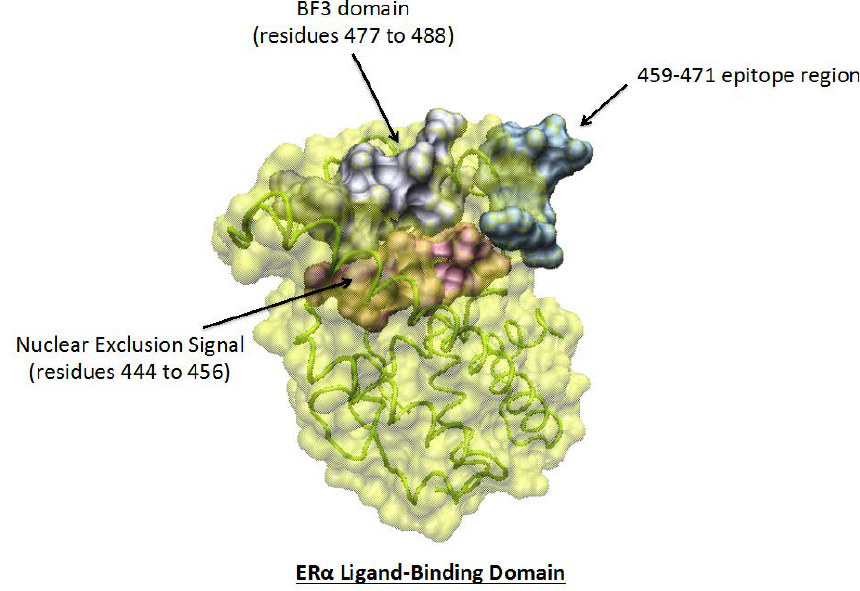
Figure 4. Surface structure of the BF3- (in grey) and ER α AB epitope/E 2 (in blue)-binding domains of the human estrogen receptor α (ER α in yellow, Connolly surface). The BF3 domain is composed of two regions, i.e., the 365–369 type II β -turn region and the 477–488 helix 10 (H10) region, the latter overlapping the 479–485 sequence implicated in the dimerization of the receptor. The ER α ABs epitope is in close contact with this BF3 domain, as well as the 444–456 nuclear exclusion site (nes, for nuclear exclusion signal, in pink). Interaction between the 301–311 region with the 365–269 type II β turn seems to repress the dimerization potency of the 477–488 helix. Transparency allows the visualization of the helices (in green) that comprise the receptor.